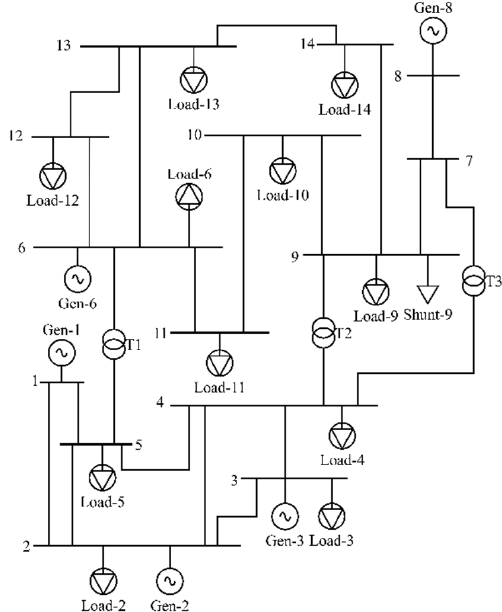
Figure 2. IEEE 14-bus test system.